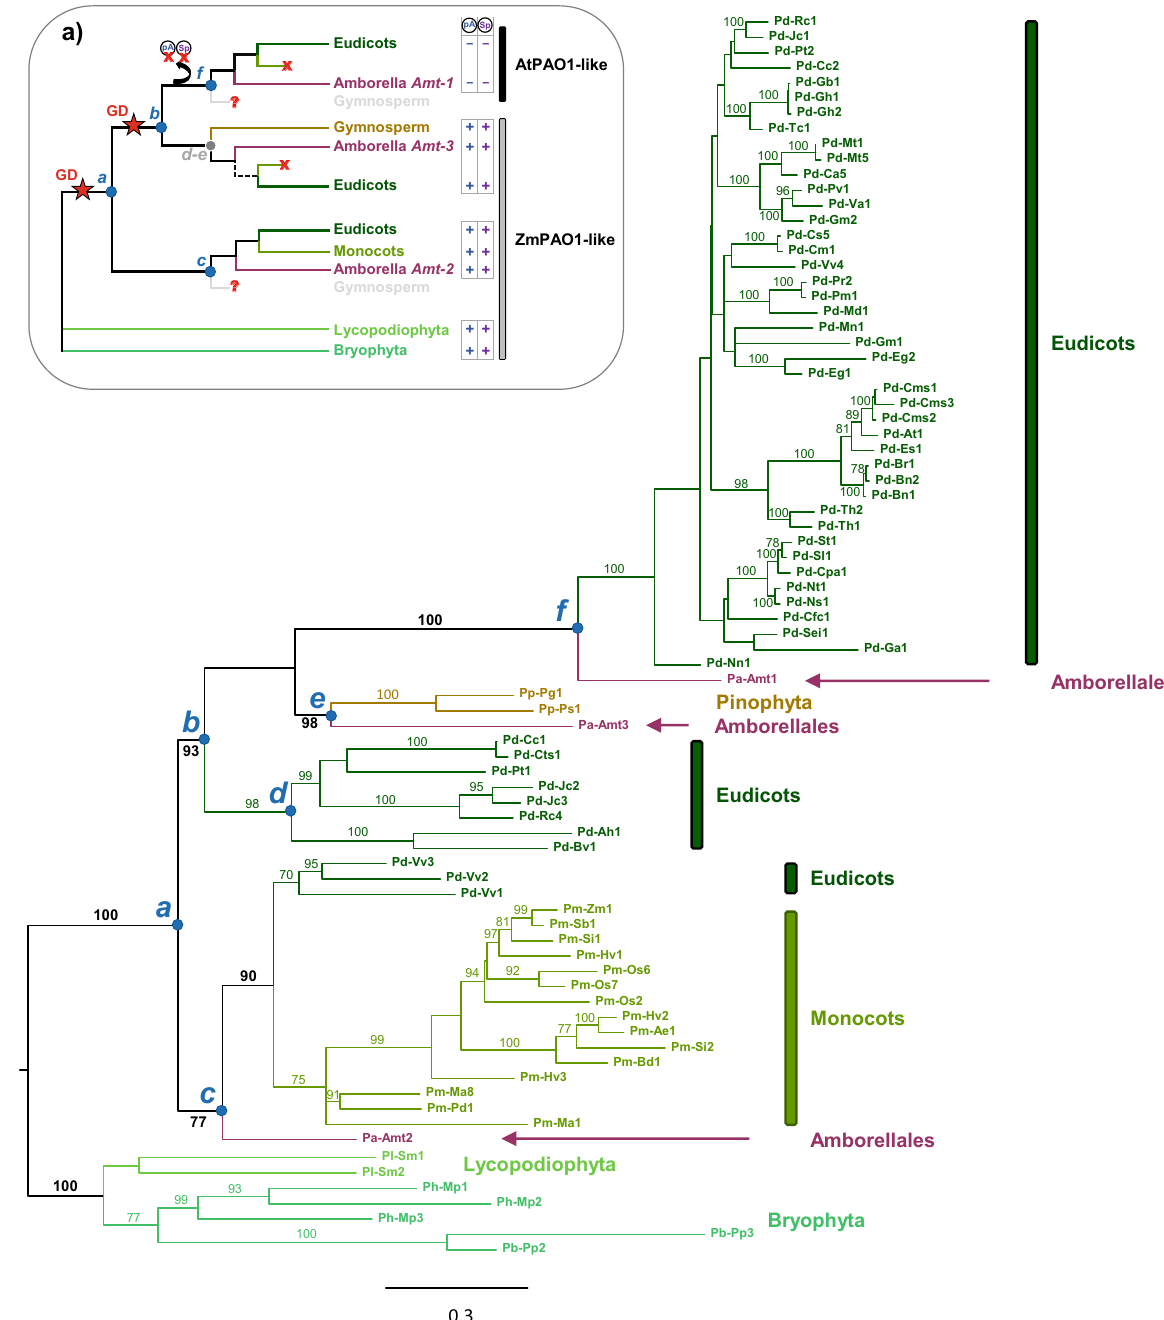
Figure 3. Maximum likelihood phylogeny of plant PAOs of the ZmPAO1/AtPAO1-like clade (see Fig. 2) based on 81 amino acidic sequences. Main clades are labelled from a to f ; bootstrap values of support (BS) are reported along the branches (BS > 70). Box ( a ) illustrates the evolutionary model for the AtPAO1-like proteins with two gene duplications (GD) in correspondence of node a and b (giving rise to the AtPAO1 subclade) , and the loss of peptide A (pA) and of the signal peptide (sP) in correspondence of node f . Putative gene extinctions are indicated with ‘x’, whereas ‘?’ denote missing information on the Gymnosperm